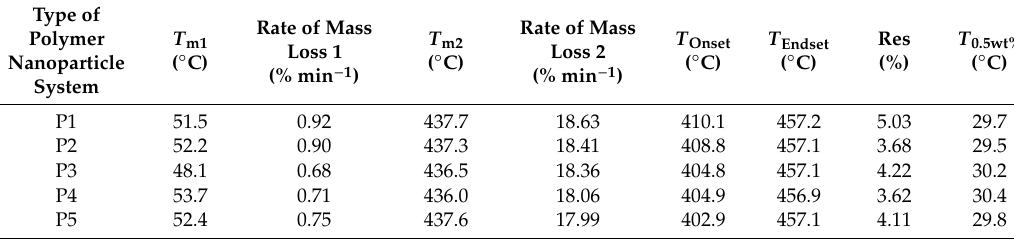
Table 2. The characteristic thermal degradation parameters of P1, P2, P3, P4, and P5.